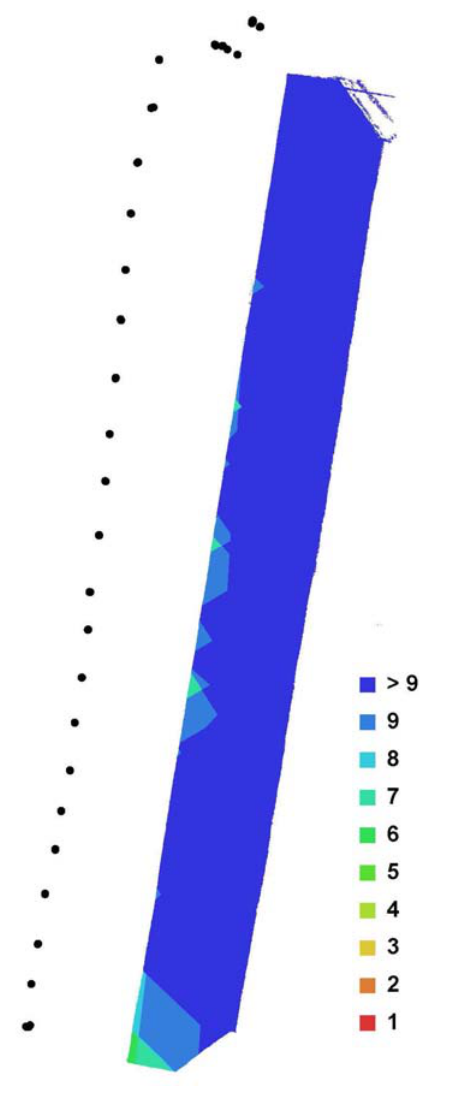
Fig. 3 Camera locations and image overlap for the roof. Lower values towards the southern end are ameliorated by additional images from ad- jacent chunks in the overall